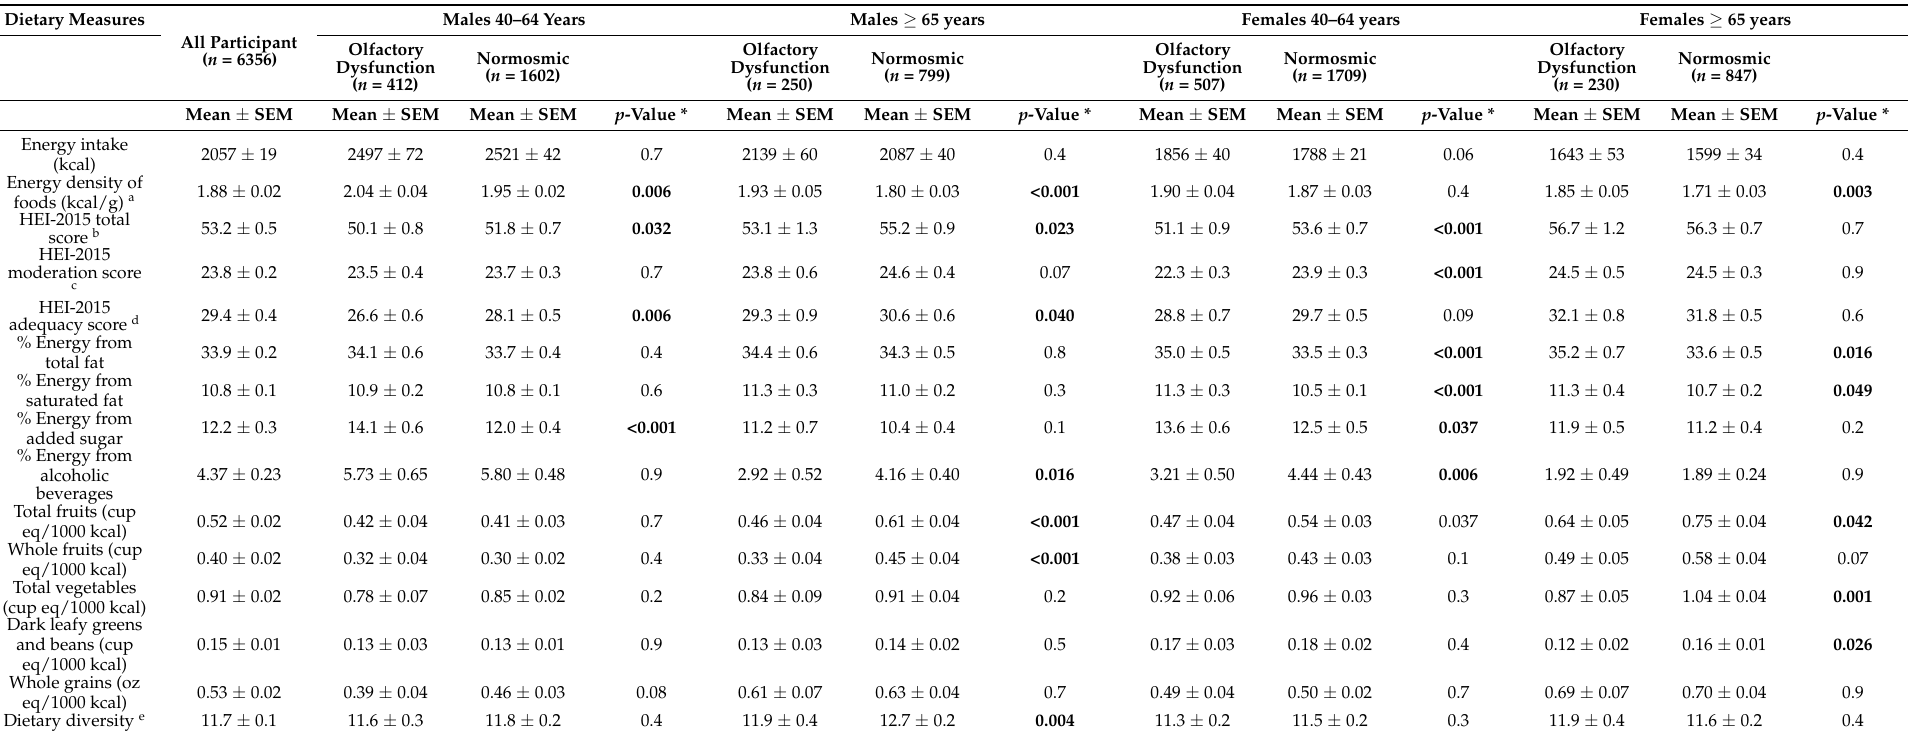
Table 2. Mean dietary attributes from a 24 h recall by age, sex, and self-reported olfactory function status among NHANES 2011–2014 participants, ages 40 years and older. Dietary